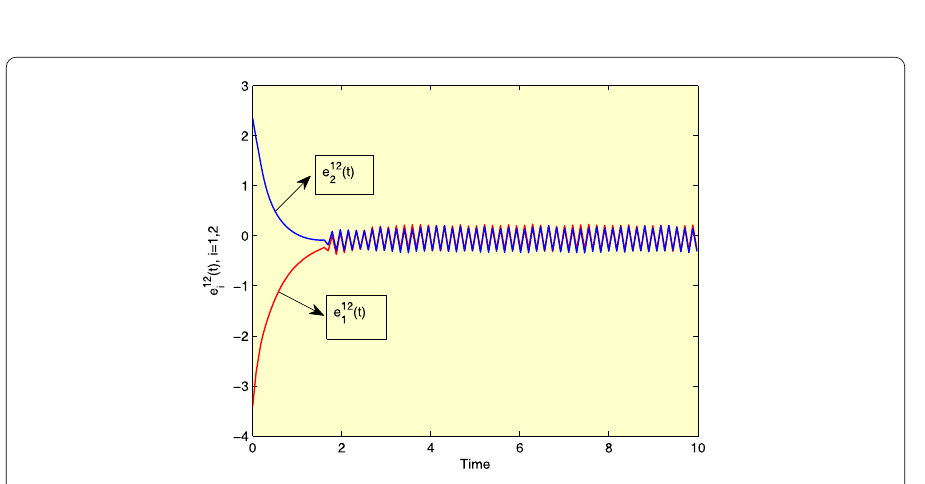
Figure 12 Synchronization curves of state variables e 12 1 ( t ), e 12 2 ( t ) of NN model (10) under controller